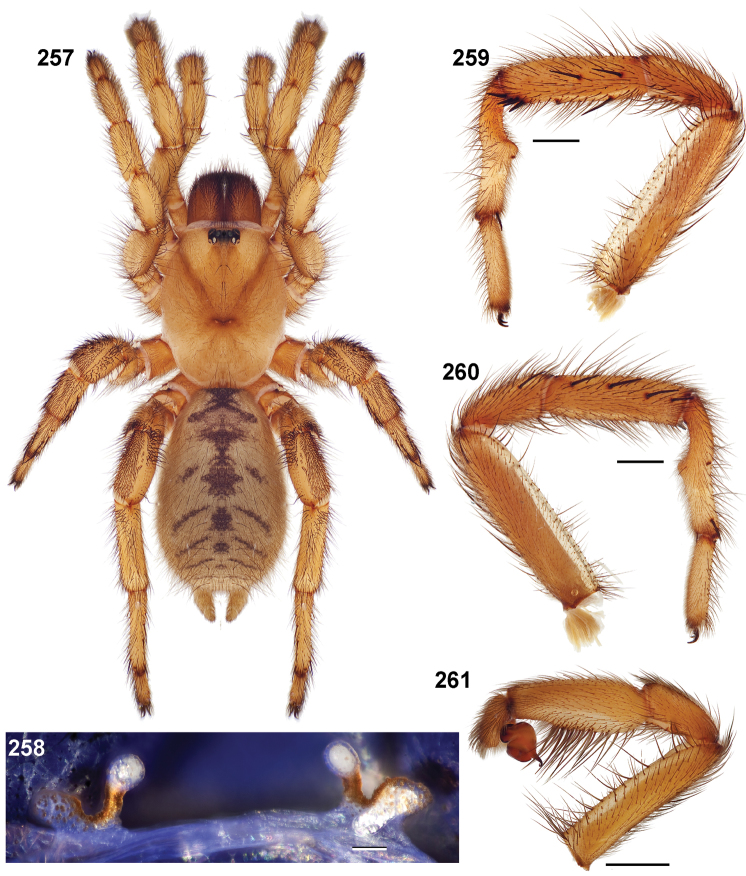
Aptostichus edwardabbeyi sp. n. 257, 258 habitus and cleared spermathecae of female paratype from Santa Cruz Co., Arizona (MY2279); scale bar = 0.1mm [806086] 259–261 male holotype (AP402) [806706]; scale bar = 1.0mm 259 retrolateral aspect, leg I [806078] 260 prolateral aspect, leg I [806076] 261 retrolateral aspect, pedipalp [806072].